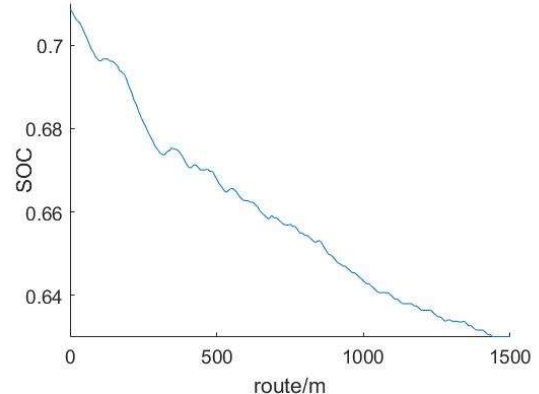
Figure 21. Logic gate control SOC .